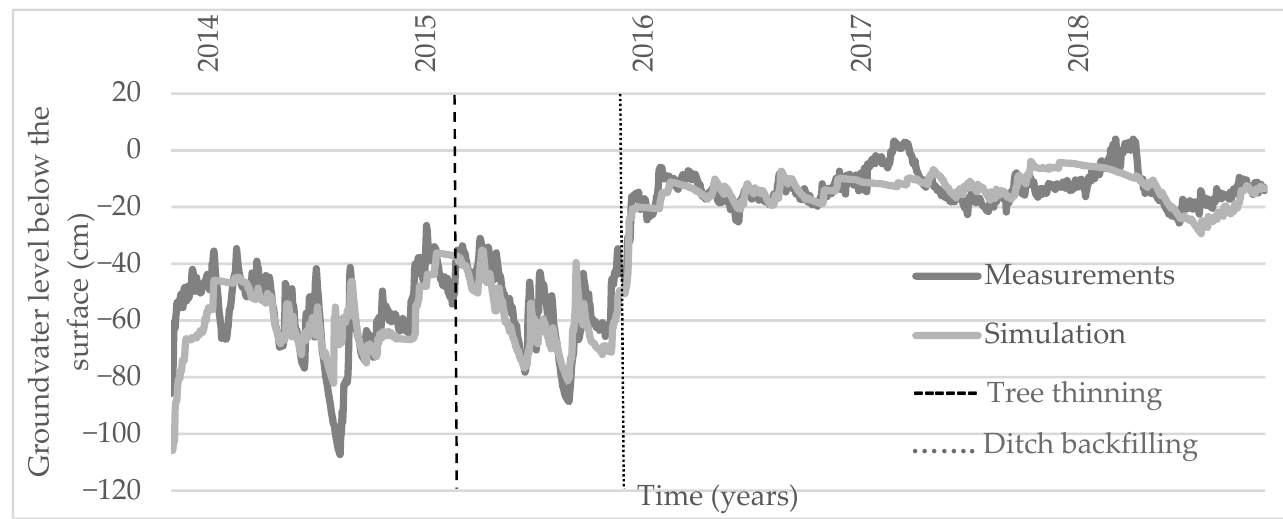
Figure 9. Plot 5 groundwater level after manipulation with the amount of precipitation. The LAI was not directly proportional to the extent of tree removals at thinning (Table 3). This can be explained by the compensatory responses of the undergrowth after opening up of the canopies (see